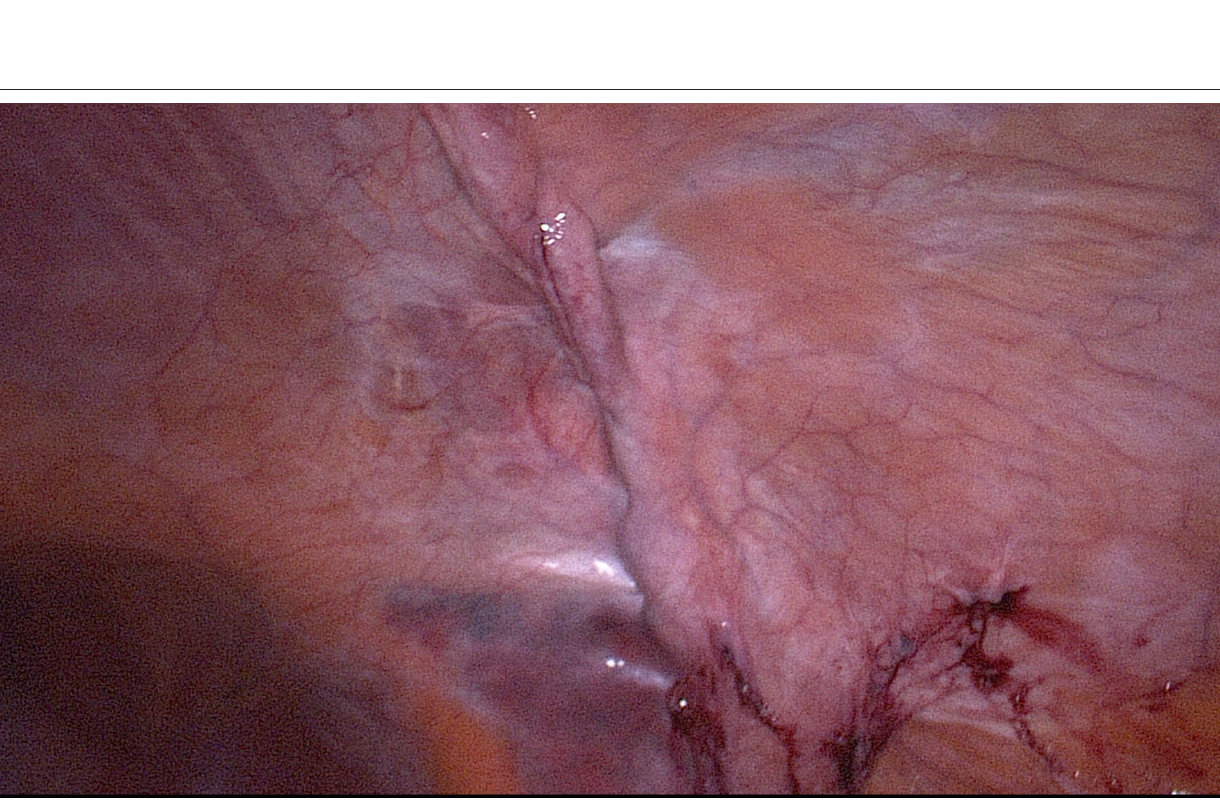
FIgure 3 | Diaphanoscopy of the fascial gap from intraabdominal perspective. The hernia margins are clearly visualized by the translucency of the fascial gap.